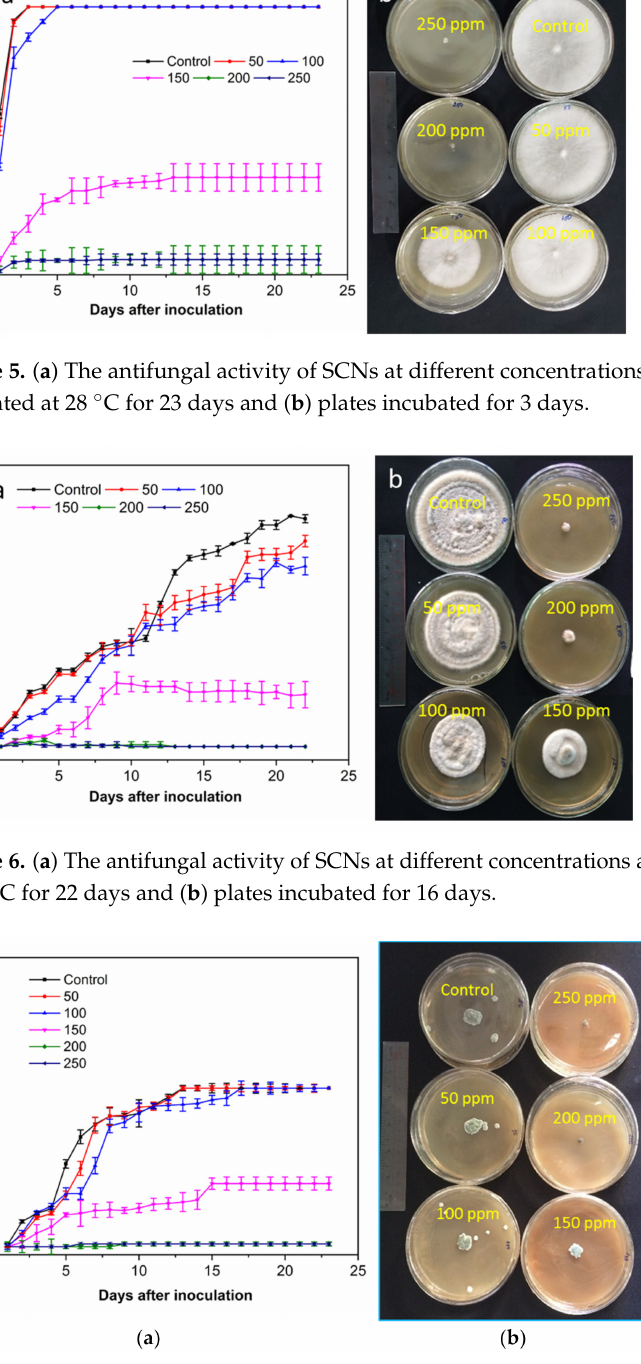
Figure 7. ( a ) The antifungal activity of SCNs at different concentrations against P. digitatum incubated at 28 ◦ C for 23 days and ( b ) plates incubated for 7